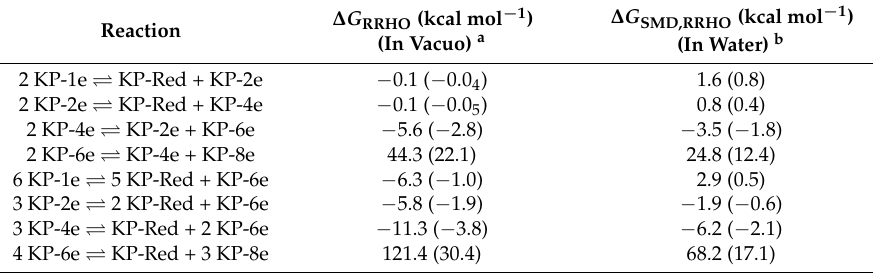
Table 18. Reaction free energies computed for several disproportionation processes involving KP.